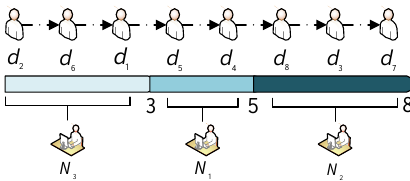
Figure 3. An example of sorted